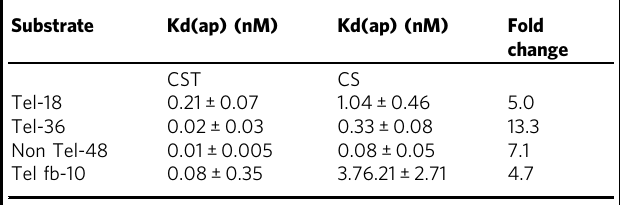
Table 1 Kd(app) for CST or CS binding to the indicated substrates